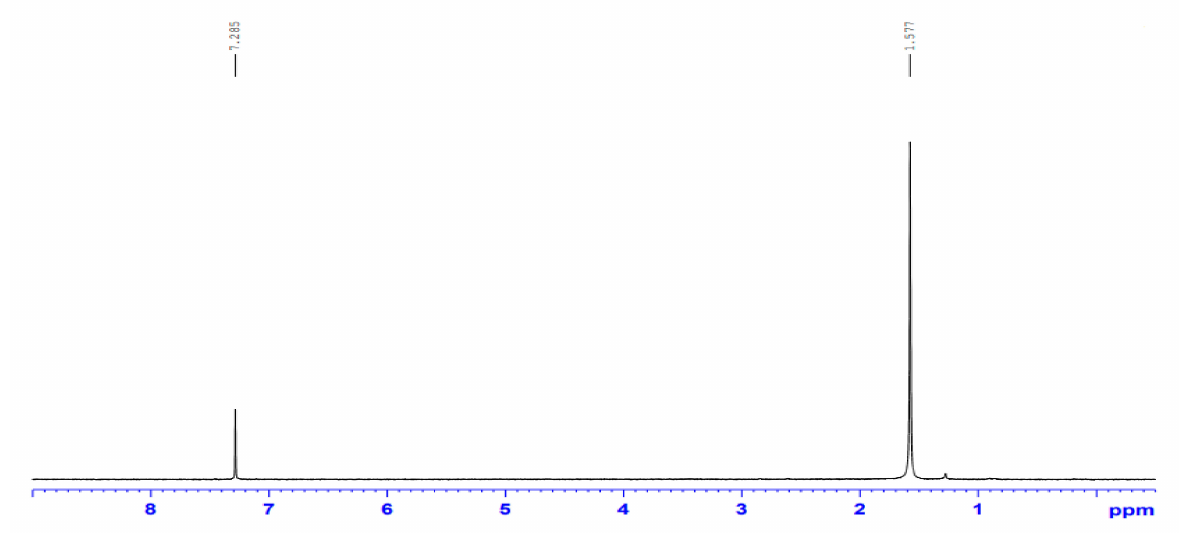
Figure 2. 13 C NMR of C 60 -AgNP